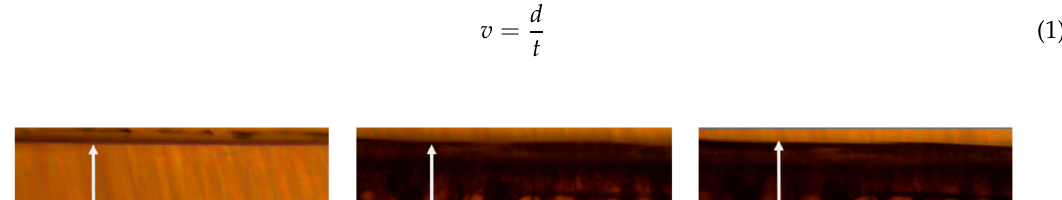
Figure 2. Scheme of a new technique for determination of the deposition rate in polymer solutions, which imitates the formation of a flat polymer membrane.